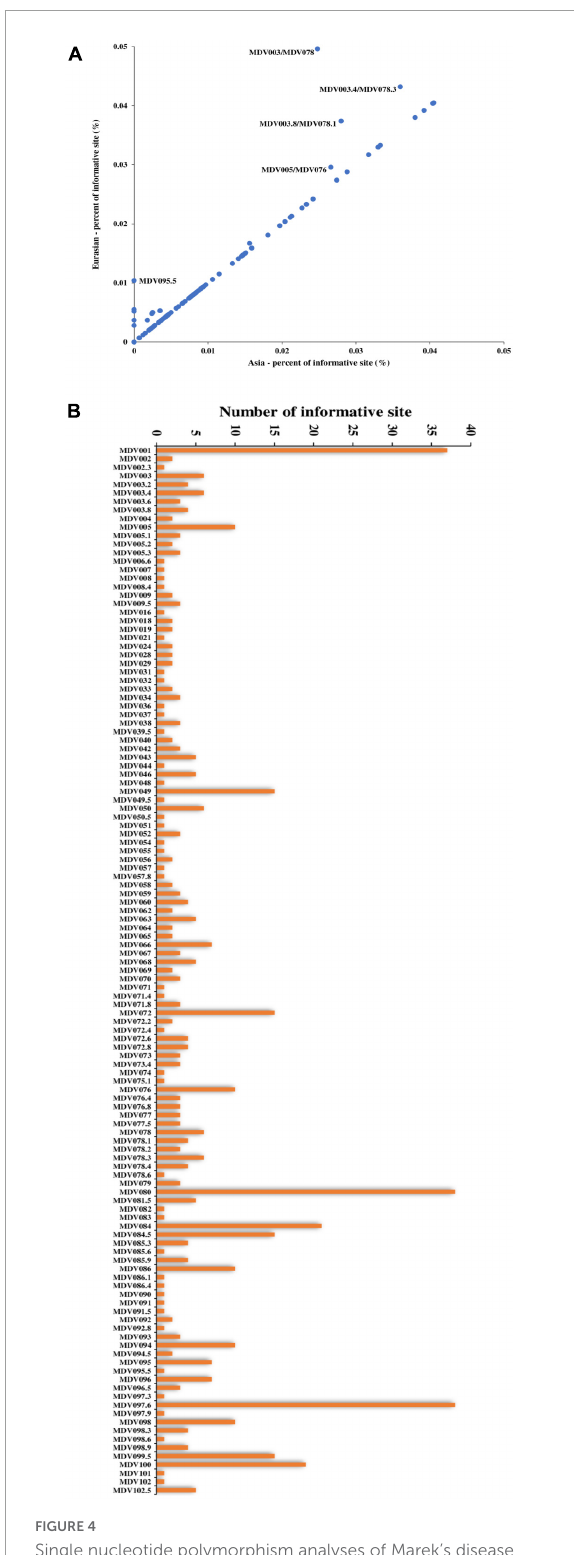
FIGURE4 Single nucleotide polymorphism analyses of Marek’s disease virus (MDV) strains. (A) Comparison of point mutations between Eurasian and Asian strains. (B) List of MDV ORFs with mutation